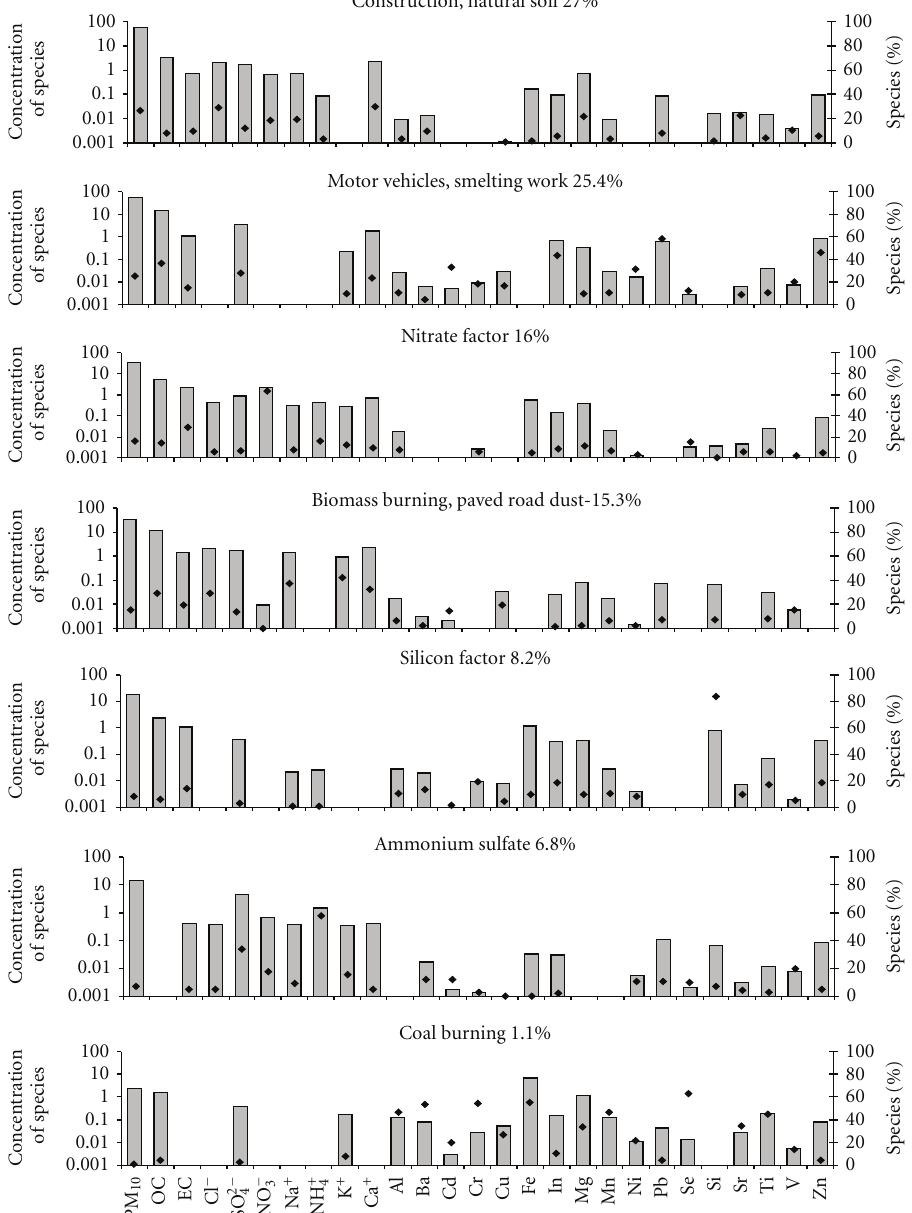
Figure 6: PMF factor profile for